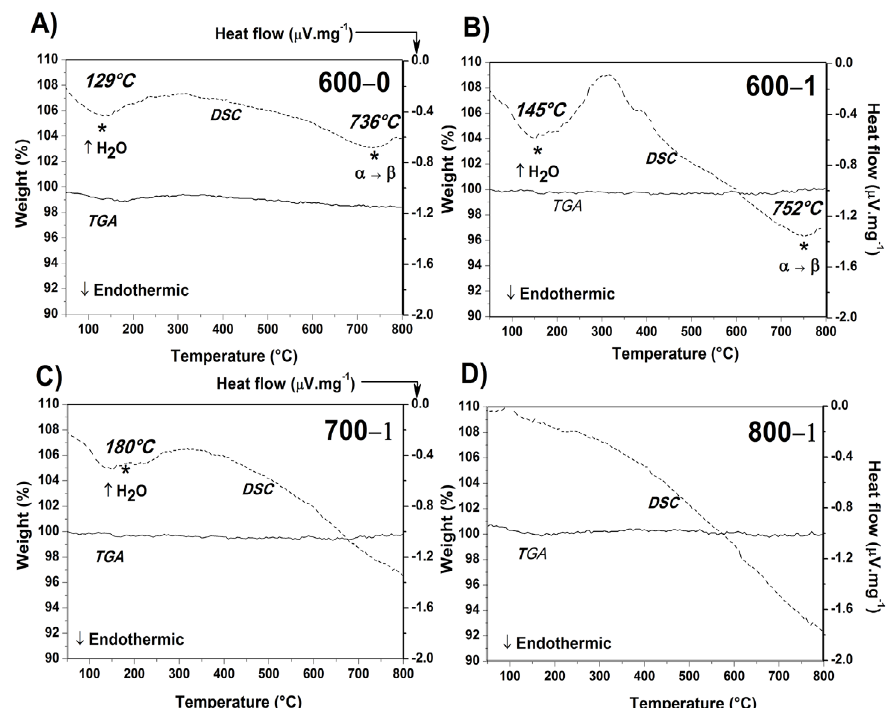
Ti O powders synthesized by combustion reaction 4 3 12